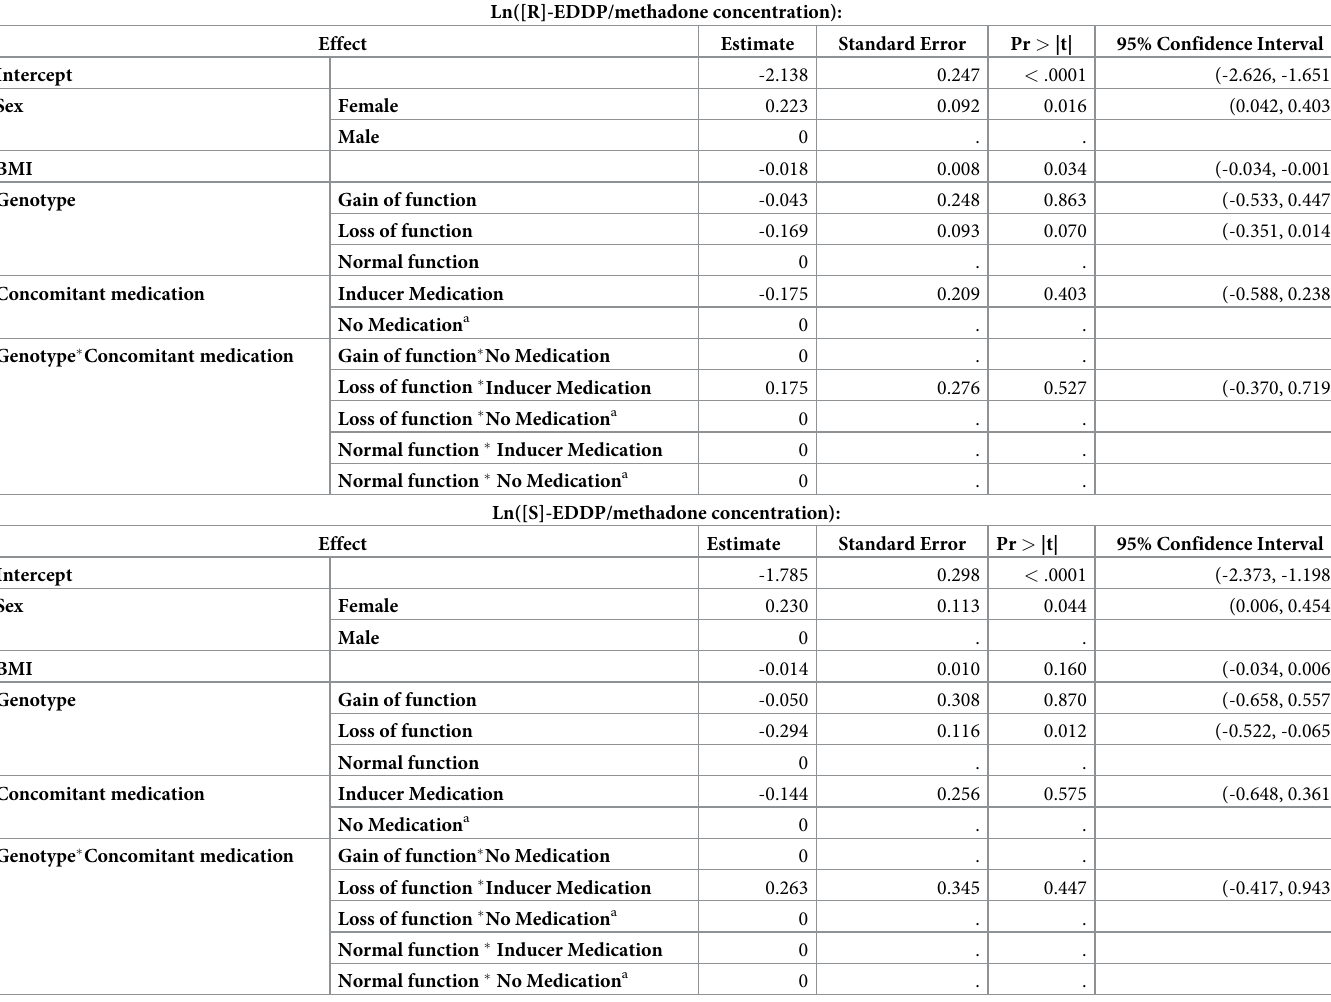
Table 6. Estimates of coefficients for fixed effects and their associated 95% confidence